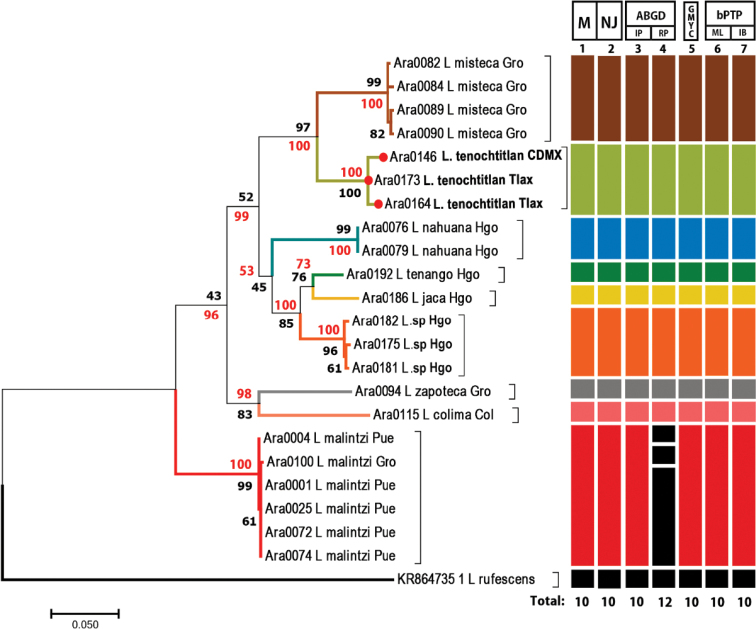
Maximum likelihood tree inferred from the concatenated matrix (CO1 + ITS2) of Loxosceles species from Mexico. Colors of branches and bars indicate different species. Numbers above bars at right represent the delimitation methods: 1: morphology (M). 2: neighbor-joining (NJ). 3: ABGD with initial partitions (IP). 4: ABGD with recursive partitions (RP). 5: GMYC. 6: bPTP with ML. 7: bPTP with IB. Numbers below bars represent species recovered for each delimitation method. Red numbers correspond to Bayesian posterior probabilities, and black numbers are bootstrap support values from the ML analysis.